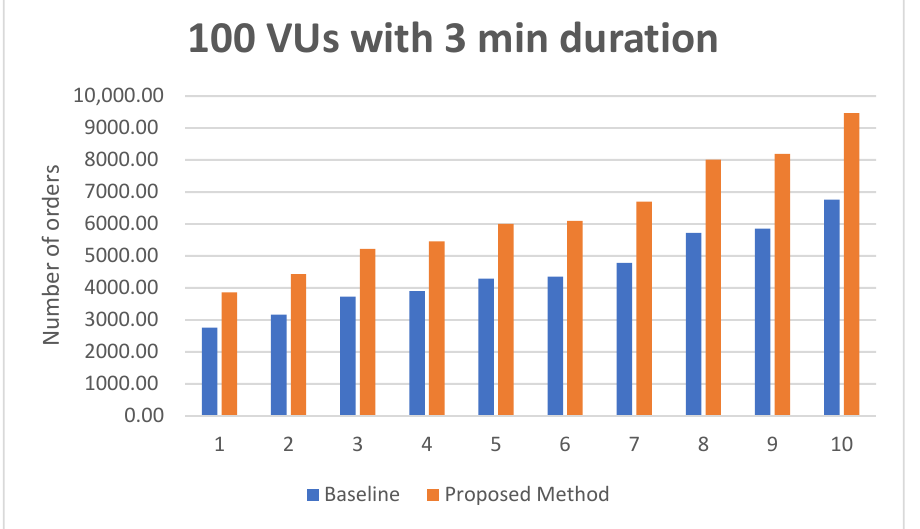
Figure 22. Load Testing—50 virtual users with 3 min duration.